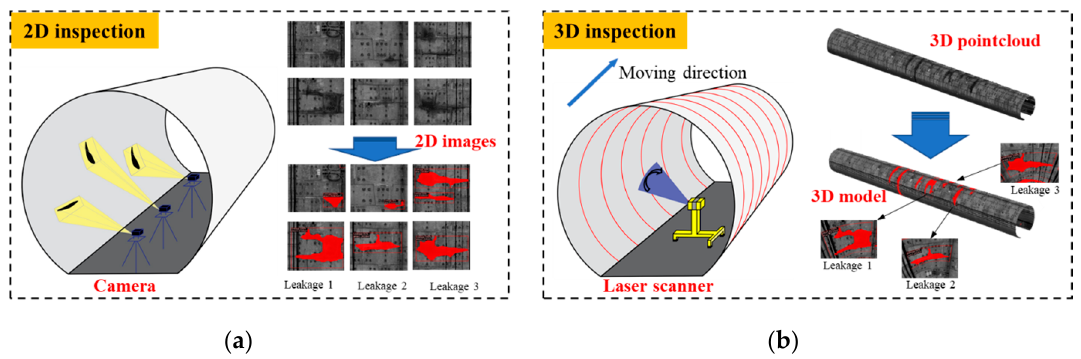
Figure 21. Differences of tunnel leakage inspection and visualization between: ( a ) a typical 2D inspection method, and ( b ) the proposed 3D inspection method.